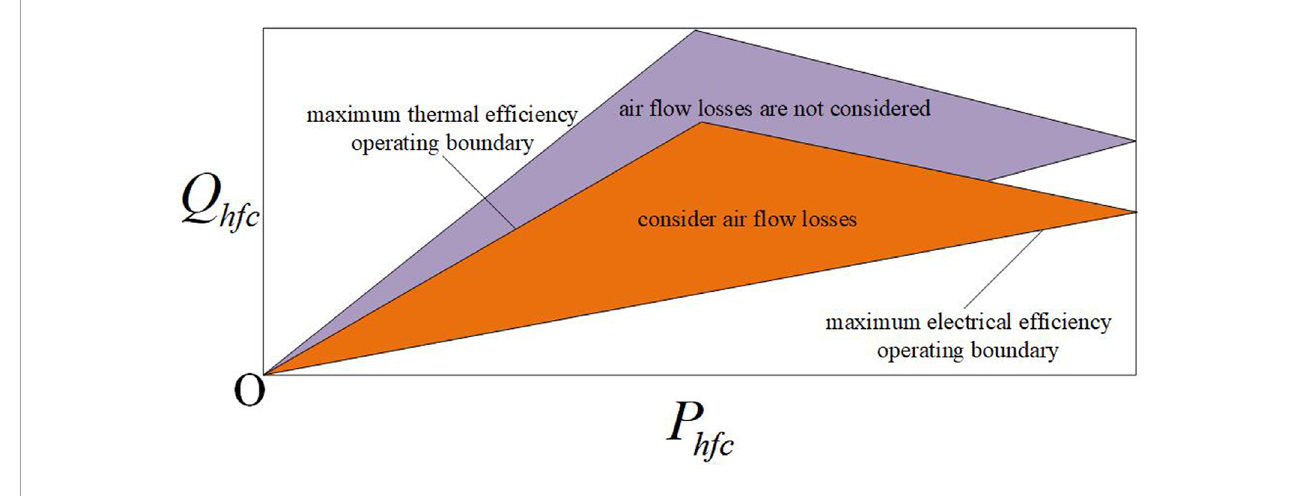
FIGURE 3 HFC cogeneration operating range.